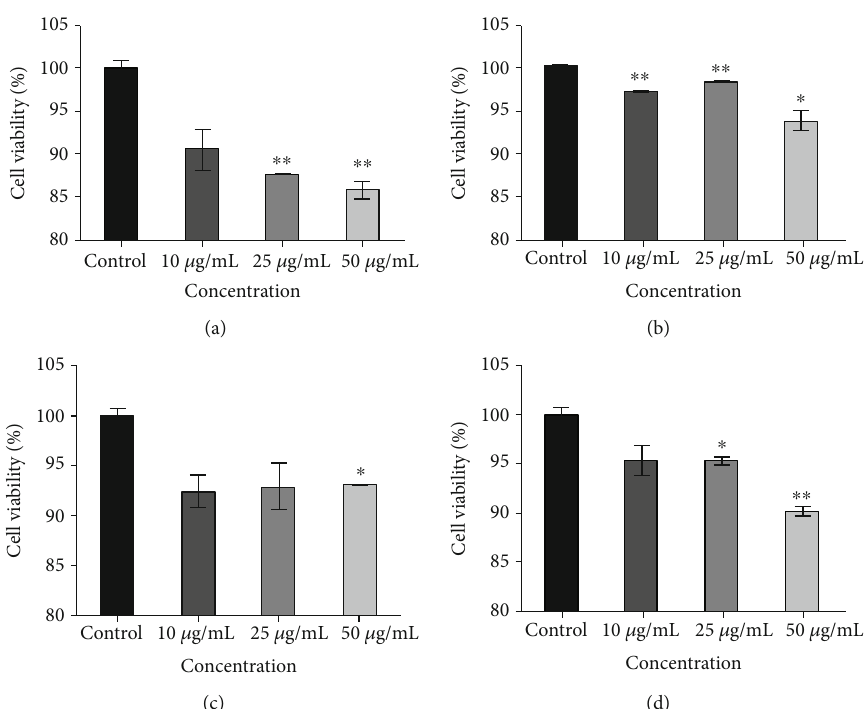
Figure 6: Cell viability using trypan blue technique of PWR-1E line after (a) 48 and (c) 72 h and PC-3 line after (b) 48 and (d) 72 h, exposed to Cs-Al NDs. Signi fi cant di ff erence with control: ∗ p < 0 : 05 and ∗∗ p < 0 : 01 .